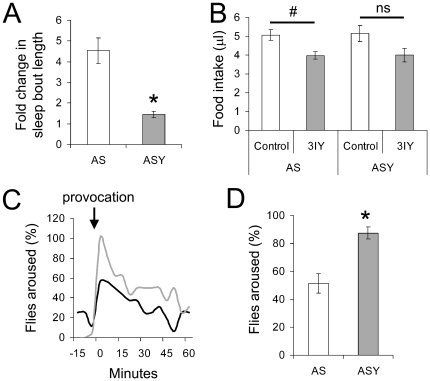
Dietary yeast affects arousal.The behaviour of male flies was assessed as described in Figure 1 and the Methods section. (A) The graph shows the fold change in sleep promoted by 5 mg/ml 3IY, an inhibitor of dopamine synthesis, when supplemented in either an agar-sucrose (AS) or yeast-containing AS diet (ASY). (B) CAFE data showing that amount of food ingested after five days on the AS and ASY diets, supplemented with the dopamine synthesis inhibitor, 3IY. (C) Average percentage of flies fed the AS diet or the ASY diet (black and grey line, respectively) aroused in response to a mechanical provocation (arrow) performed at ZT16. (D) Quantified data for the provocation test. #P<0.01, *P<0.01; CAFE assays used 9–10 flies per treatment; for the arousal provocation tests (C and D) two independent trials were performed involving 16 flies for each treatment.